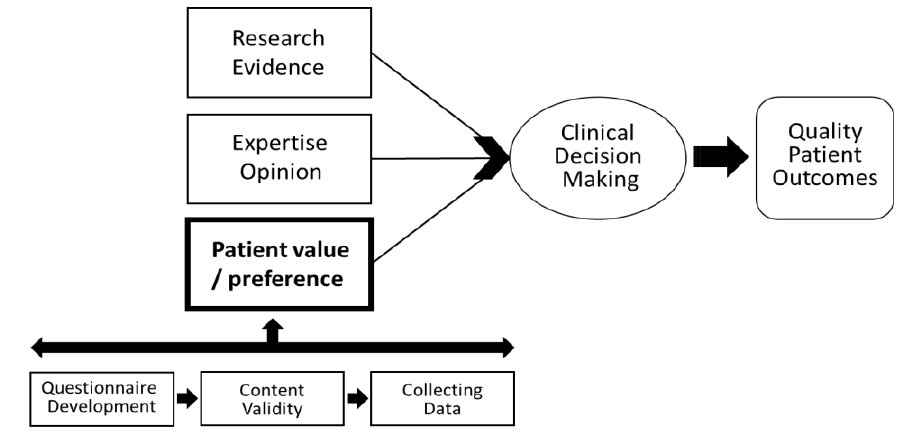
Figure 1. Research framework [21].